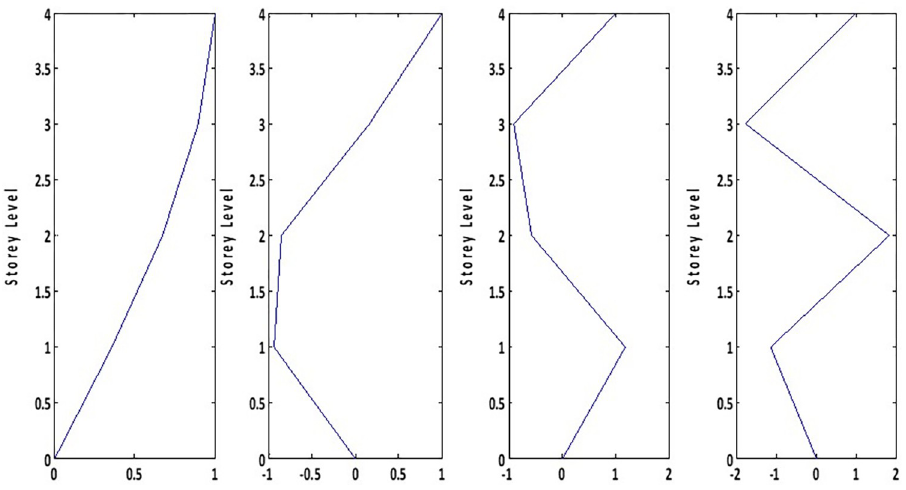
Fig 3. Mode shapes of the